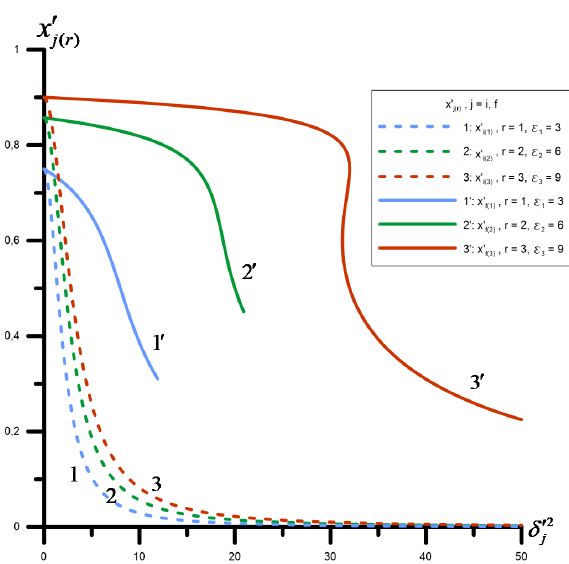
Figure 3. The hard gamma-quantum resonant frequency dependency on the emission angle. The dashed lines demonstrate the first three resonant frequencies for the channel A (34) ( j = i ) , the solid lines designate the first three resonant frequencies for the channel B (38) and (43) ( j = f ) . For the lines 1 (cid:48) and 2 (cid:48) , the emission angles of a spontaneous photon are limited by the maximal magnitude (37). The line 3 (cid:48) has a specific radiation diapason (41) with three solutions of the resonant frequency (43). The characteristic parameter ε 1 = 3 (the characteristic energy is E 1 = 100 MeV, the initial electron energy is E i = 300